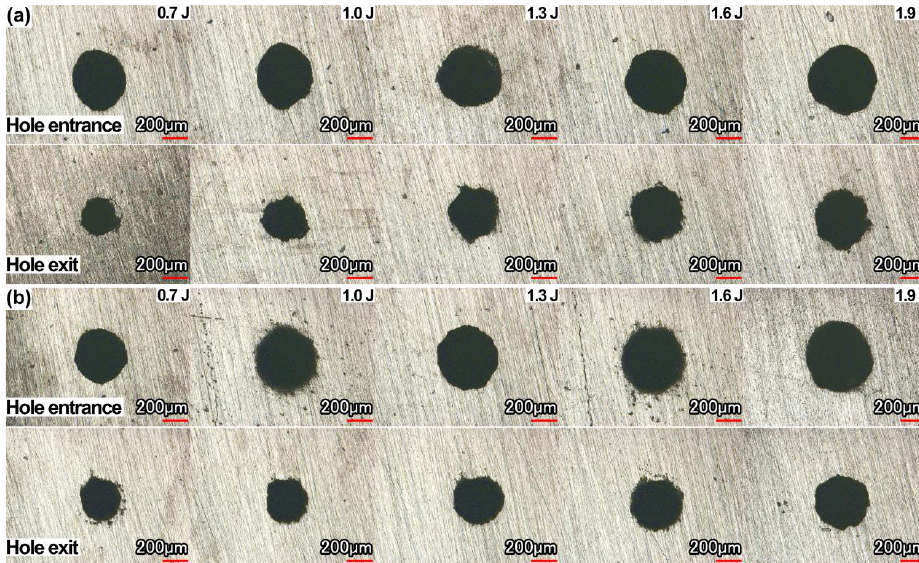
Figure 5. Effect of pulse energy on the morphology of hole entrance and exit: ( a ) in air, ( b ) water-based assistance.